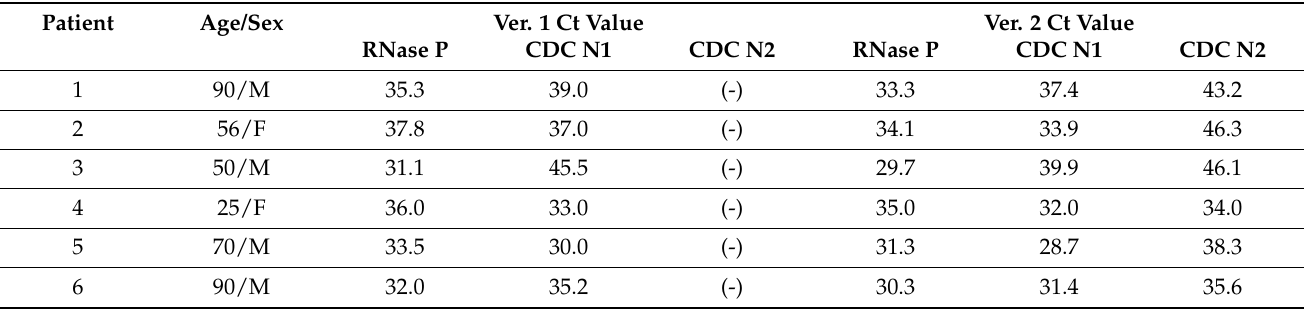
Table 1. Detection of severe acute respiratory syndrome coronavirus 2 (SARS-CoV-2) viral RNA (CDC Nl and N2) in patients with COVID-19 by PCR1100 using versions 1 and 2.